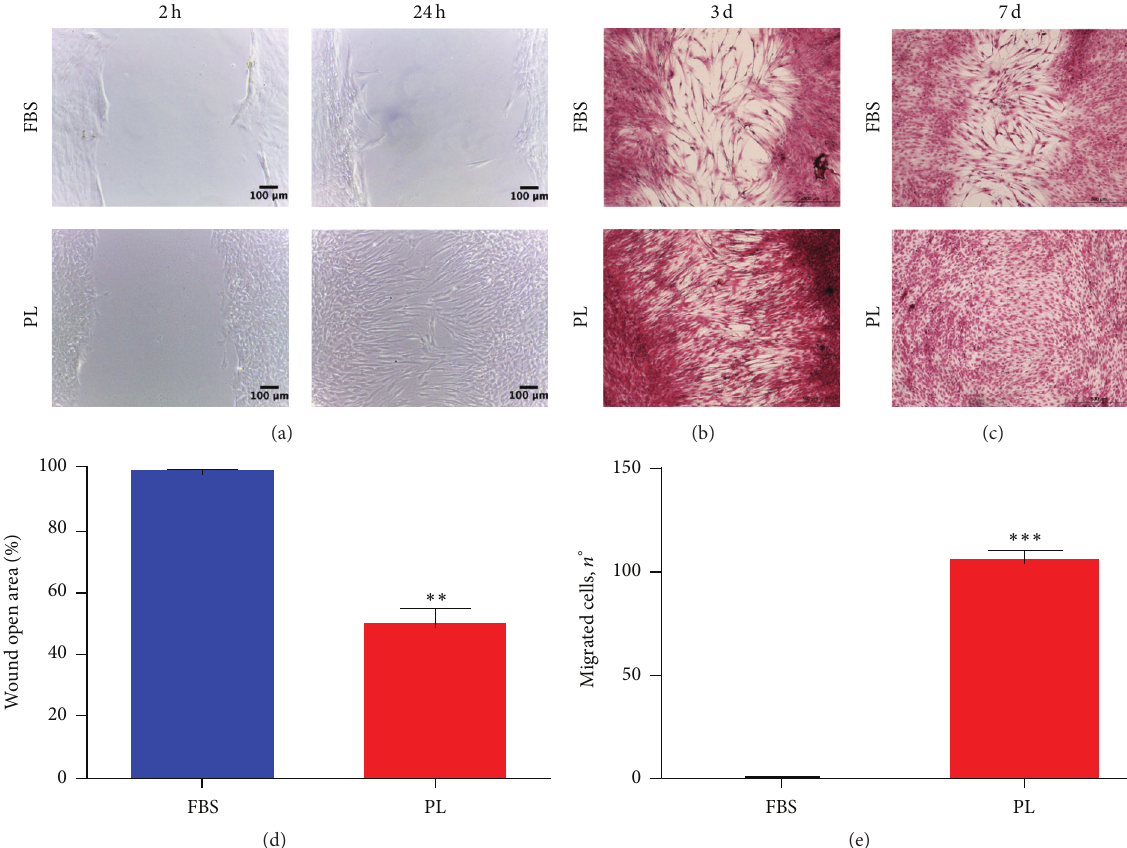
Figure 3: In vitro migration capacity of DPSCs is enhanced by PL. (a) Representative images of early time points during the scratch assay. Images were taken 2hrs and 24 hrs after the initial scratch and are representative of 3 independent experiments. The cells were fixed and stained at different endpoints as shown in (b) for 3 days and (c) 7 days. (d) Quantitative analysis of wound healing at 24 hrs after scratch. 100% is set as open area 2 h time points. Data shown as mean + SD, 𝑛 = 3 . Statistical significance determined using unpaired 𝑡 -test ( ∗∗ 𝑃 < 0, 1 ). (e) Quantification of chemotaxis derived from under-agarose assay. Data were collected using 24 h time points light microscope images. Data shown as mean + SD, 𝑛 = 3 . Statistical significance determined using unpaired 𝑡 -test ( ∗∗∗ 𝑃 < 0.001